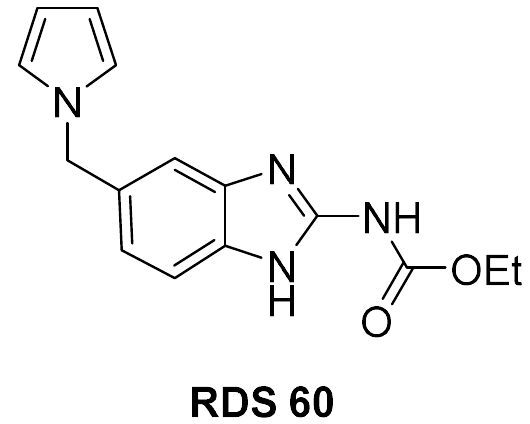
Figure 1. Chemical structure of RDS